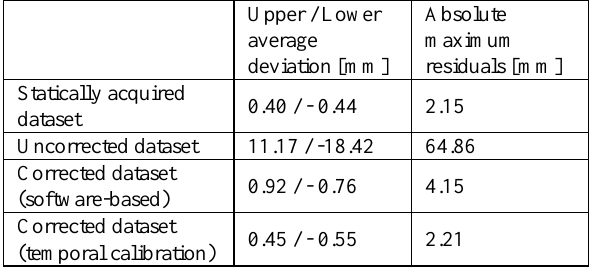
Table 1: Deviations of acquired point clouds in relation to an adjusted plane